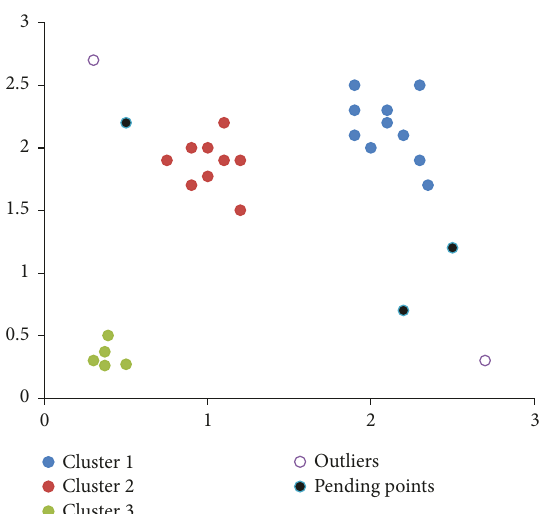
Figure 9: The distribution of points ’ roles when r is